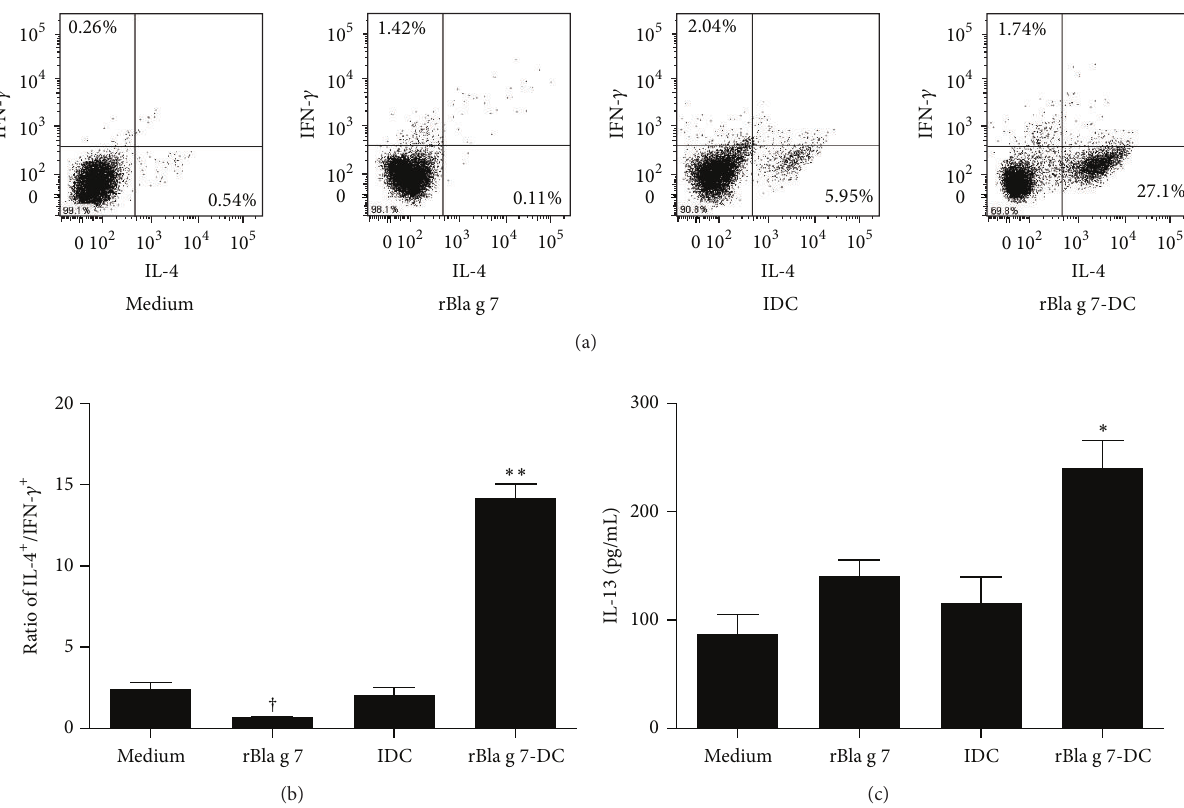
Figure 5: Induction of Th2 polarization by rBla g 7-stimulated dendritic cell (DC)s. Isolated CD4+ T cells were cocultured with immature DCs (iDC), rBla g 7-activated DCs (rBla g 7-DCs), or rBla g 7-pulsed alone (rBla g 7) for 48 h at 37 ∘ C before being harvested for analysis. (a) Flow cytometry analysis of intracellular expression of IFN- 𝛾 and IL-4 by using the fluorescent-labeled antibodies. It was noticed that the number of IL-4+ cells in the lower right quarters of IDC and rBla g 7-DCs groups was increased. (b) The ratio of IL-4+ CD4+ T cells versus IFN- 𝛾 + CD4+ T cells. (c) Levels of IL-13 in the culture supernatants determined by ELISA. The data were represented as the mean ± SEM for four separate experiments. ∗ 𝑃 < 0.05 , ∗∗ 𝑃 < 0.01 in comparison with medium alone control. † 𝑃 < 0.05 for decreased response in comparison with